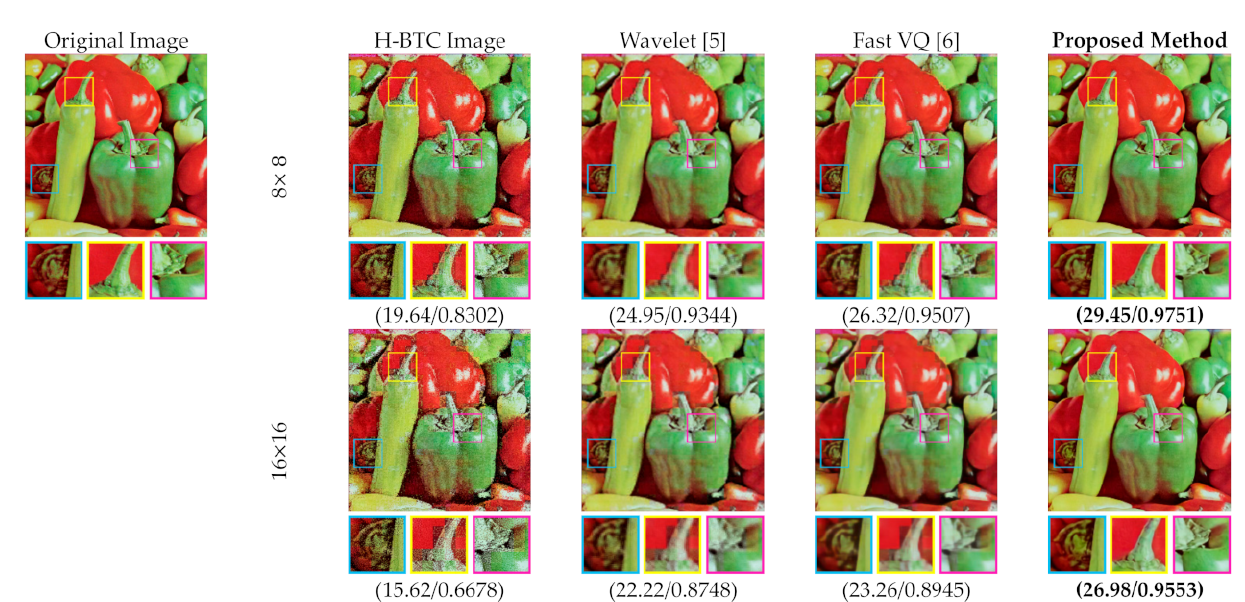
Figure 16. Visual comparisons between the proposed method and former schemes on reconstructing the DDBTC decoded image over the Peppers